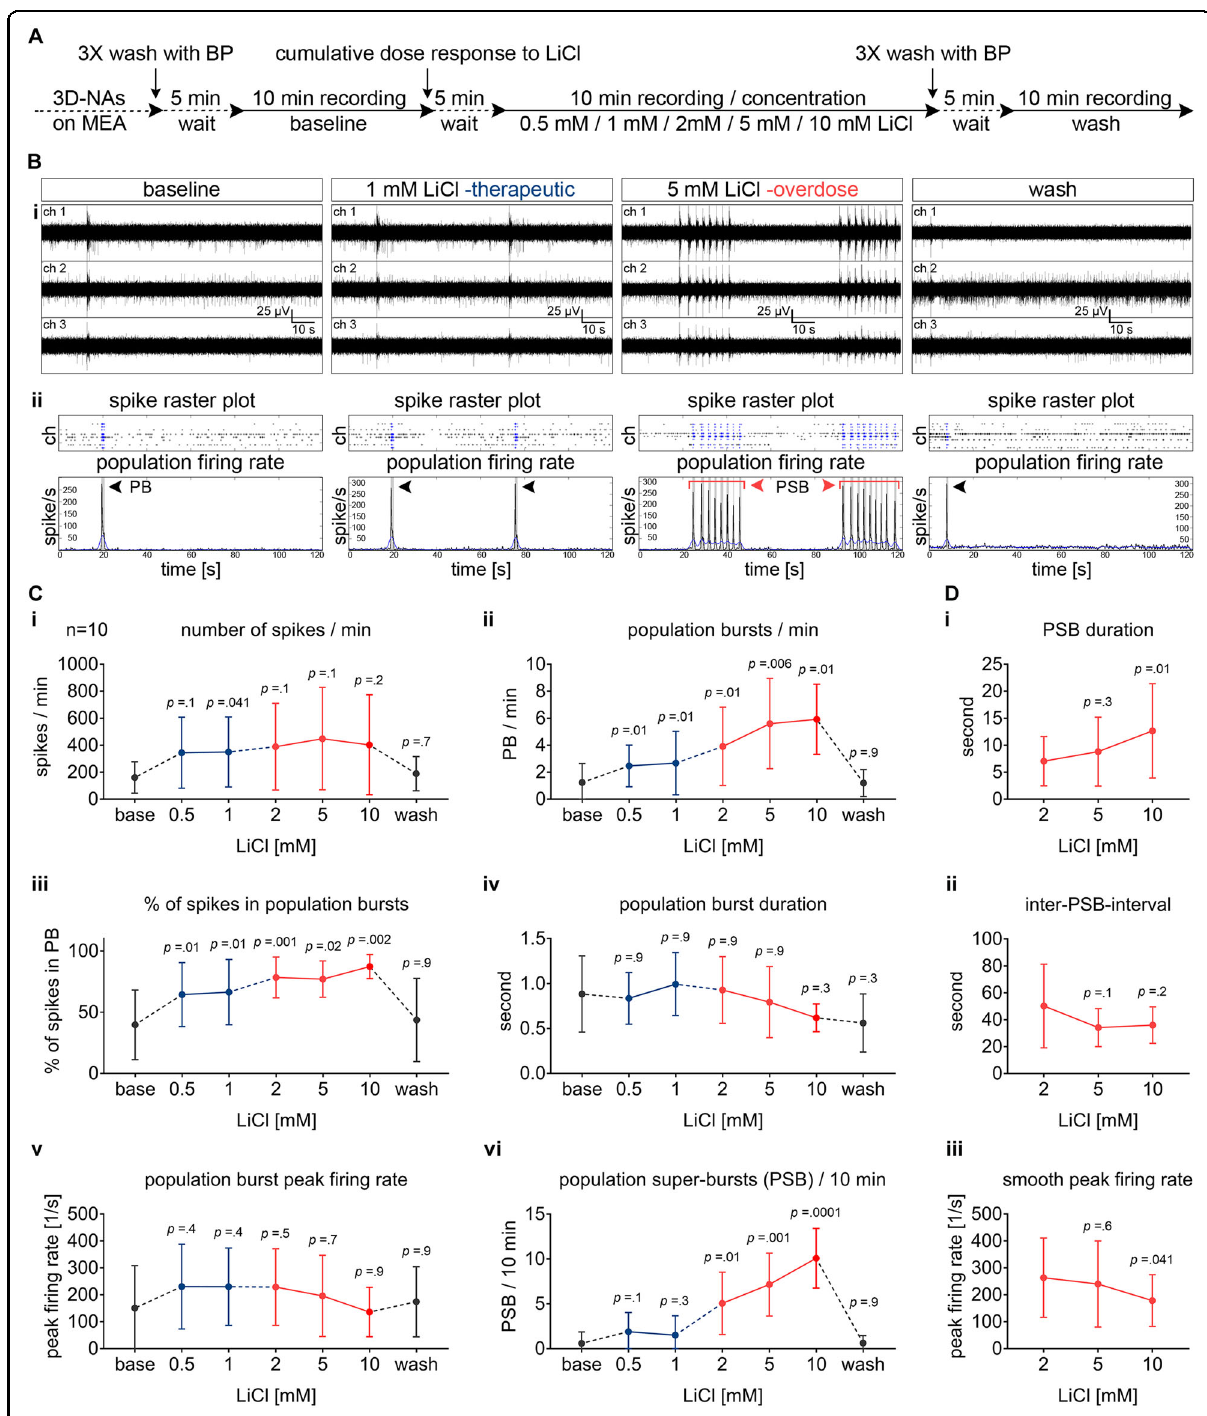
Fig. 1 Concentration-dependent bi-modulatory impact of lithium chloride (LiCl) on human cortical networks recorded by MEAs. A Schematic representation of the applied protocol to evaluate the cumulative dose – response to LiCl in the hiPSC-derived 3D-neural aggregate cultures with synchronous network activity (day 20 – 50 after seeding). B , i Representative examples of MEA-recordings (three individual channels are shown) with their corresponding B , ii Spike raster plot and population fi ring rate diagrams showing the properties of network activity in baseline and in response to therapeutic and overdose concentrations of LiCl. The black arrows are marking the population bursts (PB) and the red arrows with the red line mark the population super-bursts (PSB). C Diagrams illustrating the change of neuronal network parameters in response to increasing concentrations of LiCl in synchronously active human neuronal networks. D The properties of PSB activity in overdose concentrations of LiCl. The data are presented as mean±standard deviation, n = 10, N = 3. One-way ANOVA with Dunnett ’ s correction (baseline compared to the indicated group) was applied to calculate the shown p